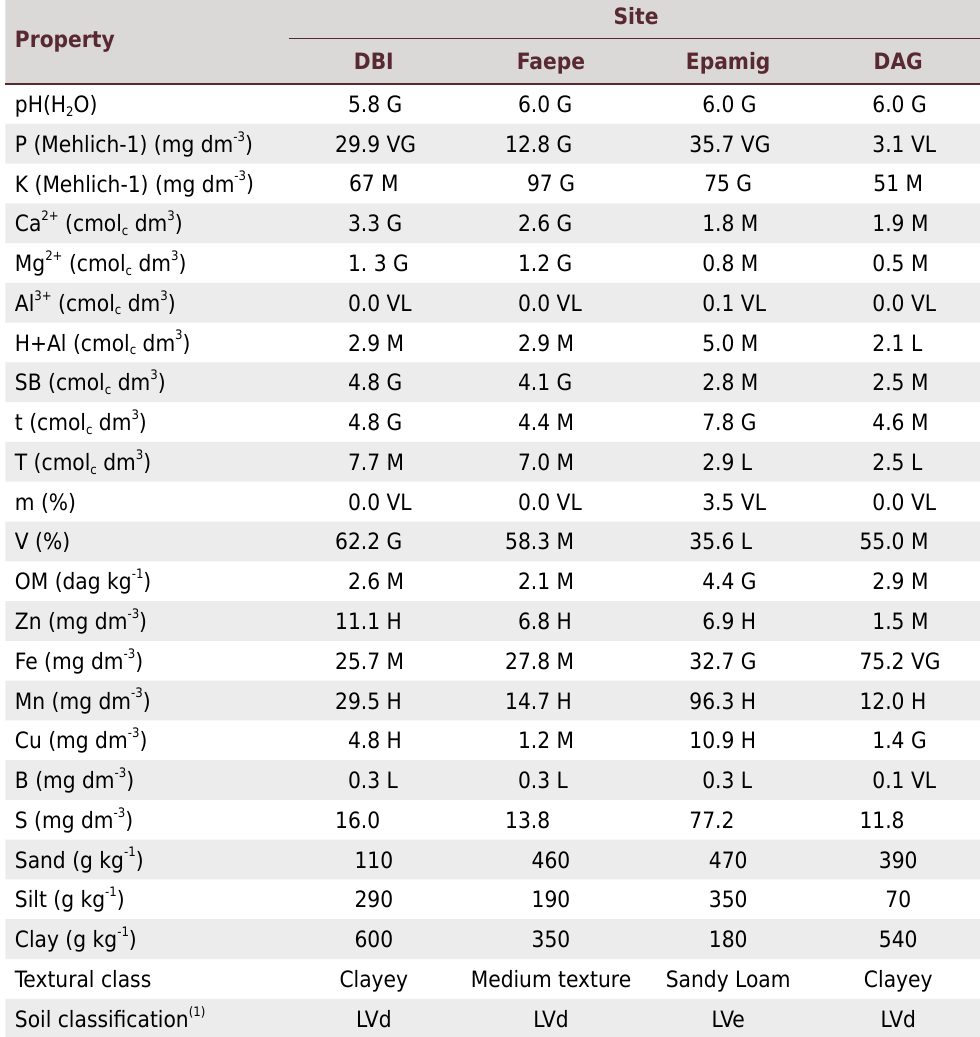
Table 2. Chemical and physical properties of soils samples (0.00-0.20 m layer), textural class, and soil classification